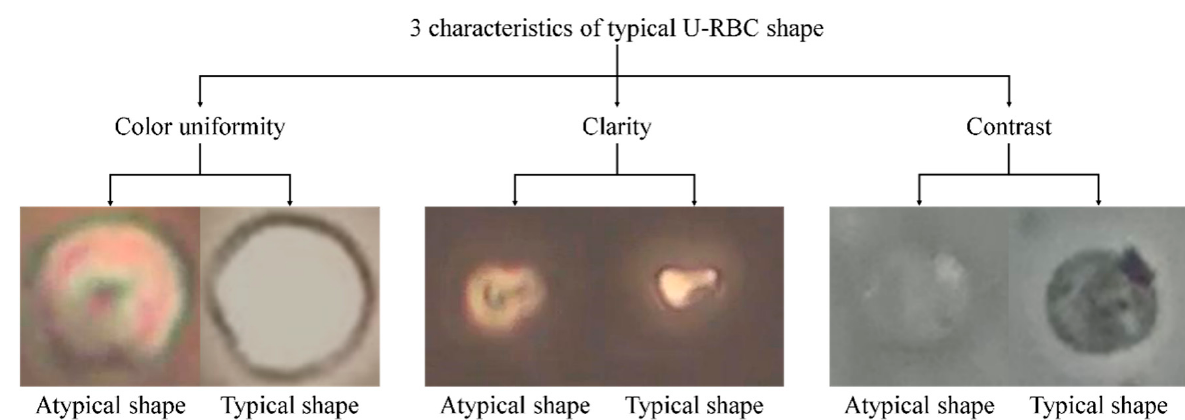
Figure 4. The 3 characteristics of typical U-RBC shapes.